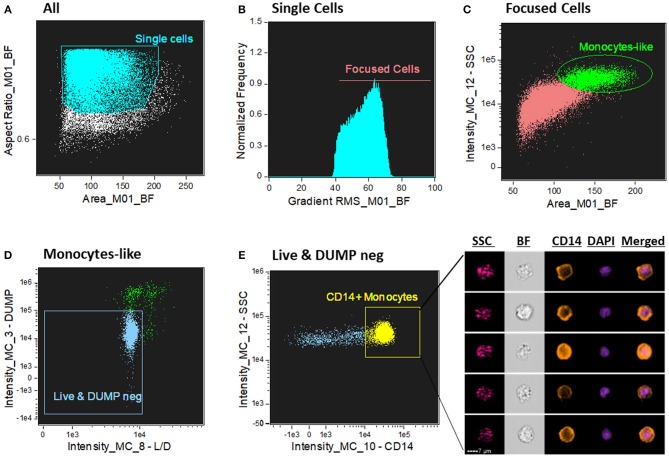
Gating strategy for CD14+ monocyte identification. (A) Dot-plot of Area vs. aspect ratio of BF (channel 1). Single cells present higher aspect ratio and mid-range area. The boundaries of the single cells gate were determined by looking at the imagery in the gallery area. (B) Histogram of Gradient RMS of the ch1 (BF) to select cells in good focus. Focused cells present greater difference with the background and consequently higher score in this texture feature. (C) Identification of monocytes by Area of the BF (ch1) vs. Side Scatter (SSC—ch12); monocytes present higher SSC values in the PBMC fraction compared to lymphocytes. (D) 2-parameter dot-plot fluorescence of Live/Dead (L/D—channel 8) cell marker (X axis) and DUMP channel (channel 3–Y axis). Double negative events for these two markers exclude dead cells and non-monocytes (CD3+, CD56+, CD19+, etc). (E) 2 parameter dot-plot of fluorescence intensity of CD14 vs. SSC. Monocytes are identified by selecting CD14+ cells. On the right side of the graph, representative images of CD14+ monocytes were selected, showing, respectively: SSC (side scatter—granularity), BF (brightfield), CD14 (orange color), DAPI (purple color) and composite image of the two fluorescence dyes (CD14 and DAPI). Intensity fluorescence was augmented for the purpose of imagery, not affecting results and statistics.